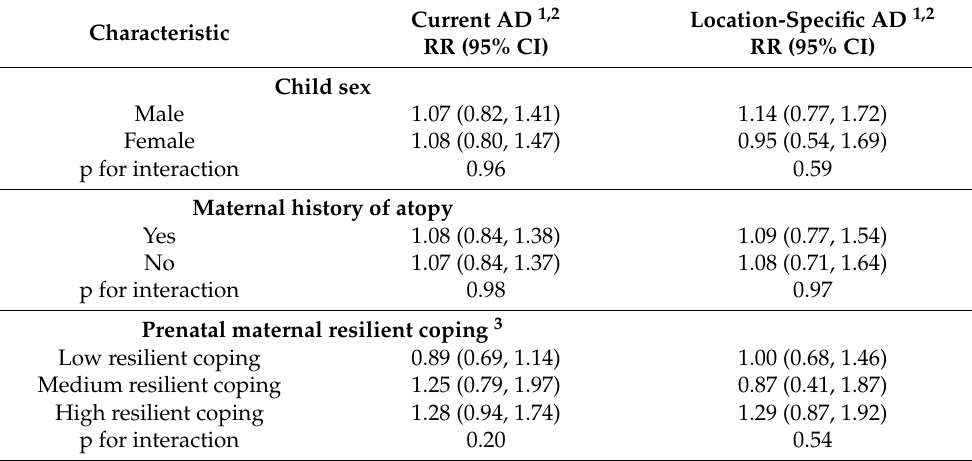
Table 3. Adjusted associations between prenatal stressful life events and child atopic dermatitis outcomes across strata of child sex, maternal history of atopy, and prenatal maternal resilient cop- ing category.